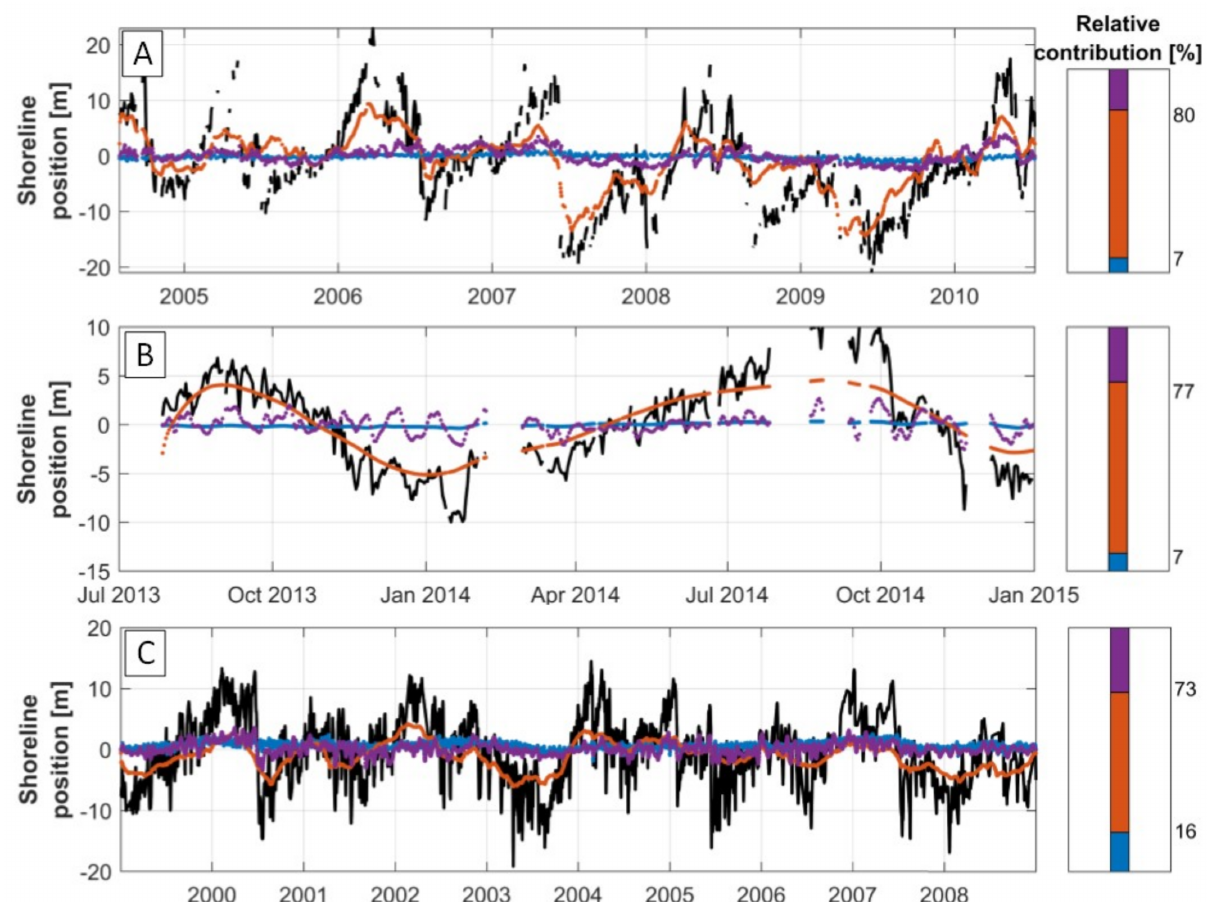
Figure 6. Contribution of each model improvement step over time (left panels) for the dataset at Narrabeen ( A ), Nha Trang ( B ) and Tairua ( C ). Note that the measured data is indicated in black and the direct forcing, upscaling and downscaling approach are indicated in blue, orange and purple, respectively. Right: the corresponding relative contribution of the three model improvement